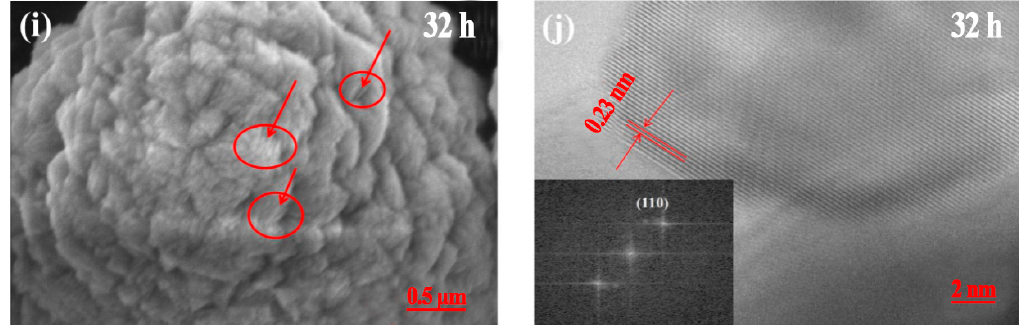
Figure 6. SEM images ( a , c , e , g , i ) and HR-TEM images ( b , d , f , h , j ) of prepared CoCO 3 under different crystallization times: 1 h (a,b); 2 h (c,d); 8 h (e,f); 16 h (g,h); 32 h (i,j). Inset of (b,d,f,h,j): fast Fourier transformation (FFT) pattern of particles.